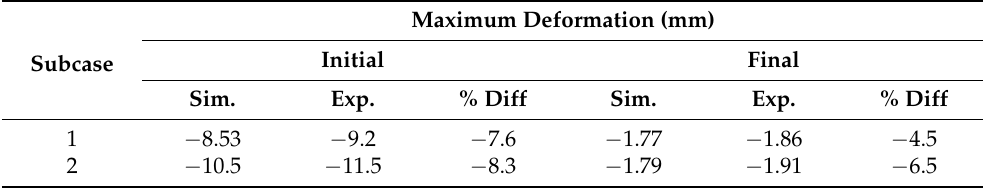
Table 4. Comparison of simulation (Sim.) and experimental (Exp.) results of case study 1—flat plate.